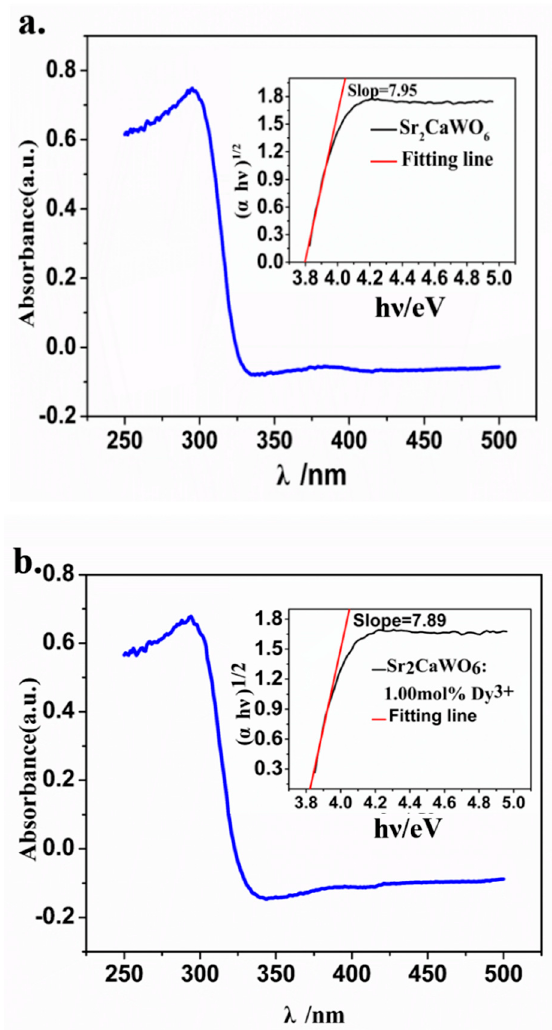
Figure 3. The UV–Vis absorption spectra of Sr 2 CaWO 6 ( a ) and Sr 2 CaWO 6 : 1.0 mol% Dy 3+ ( b ), the insert shows variation of ( α h ν ) 1/2 under different photon energy.